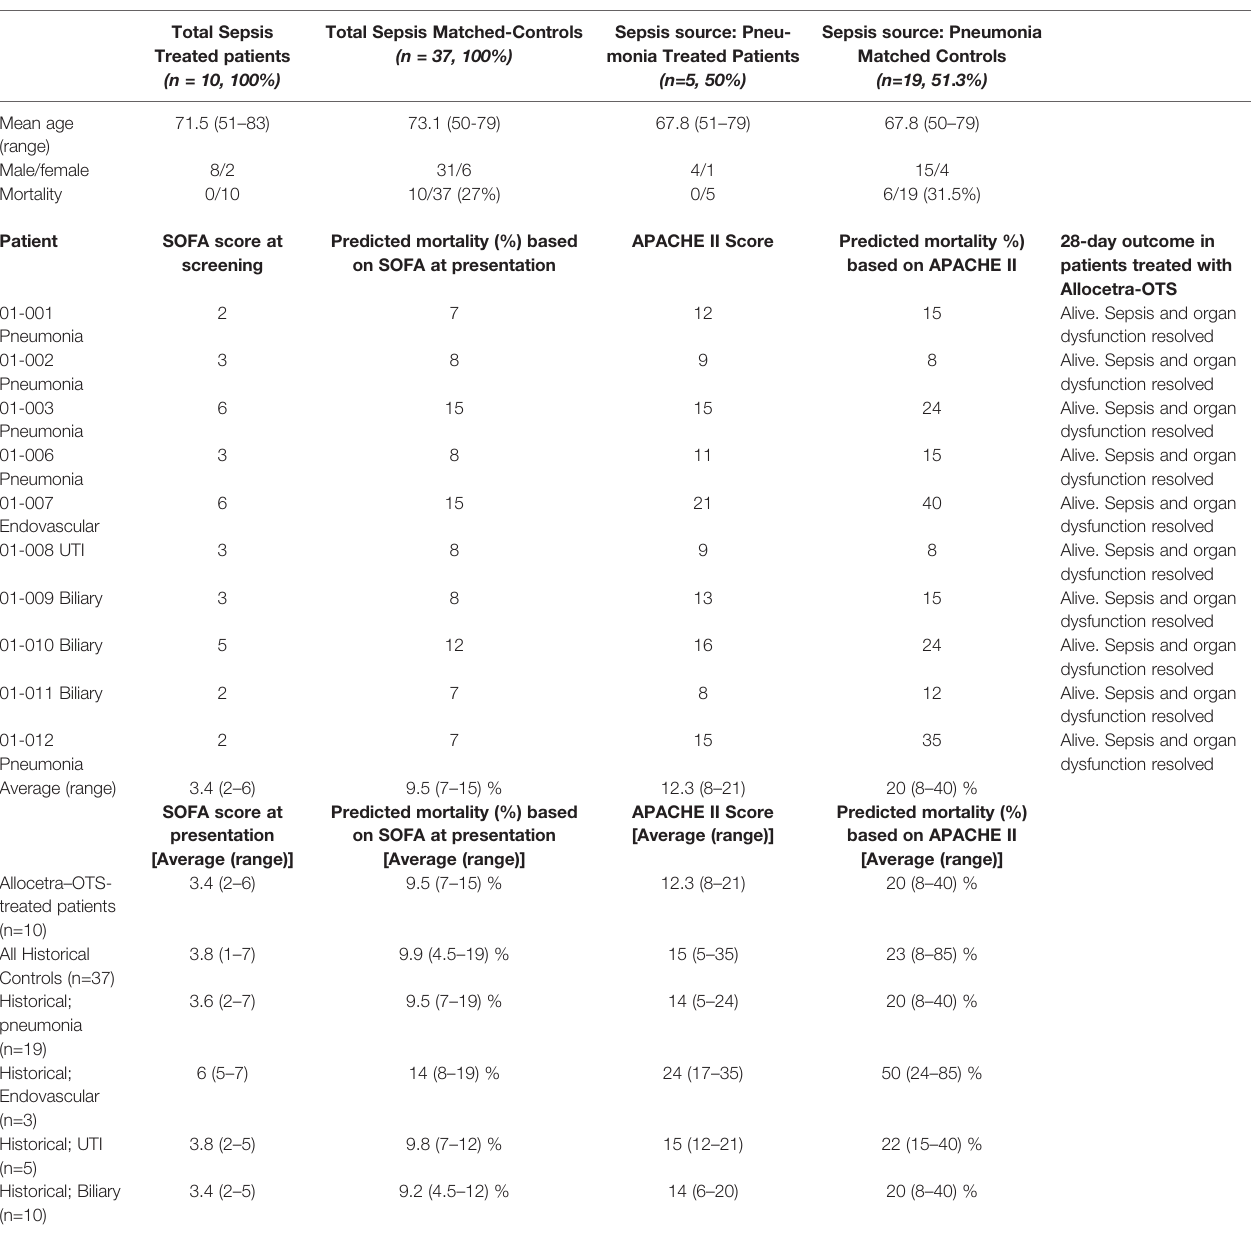
TABLE 1 | Characteristics of patients and historical matched-controls. Total Sepsis Total Sepsis Matched-Controls (n = 37, 100%) Treated patients (n = 10, 100%)